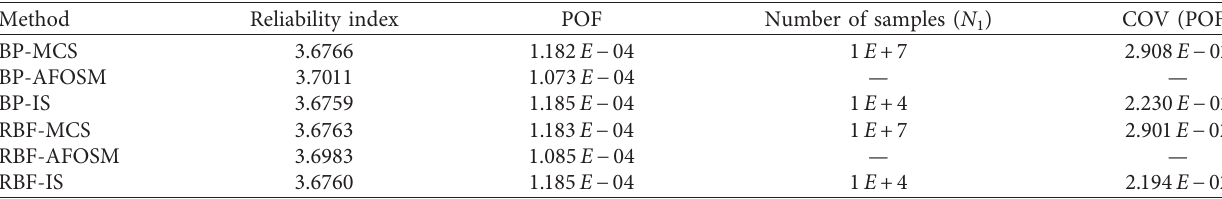
Table 10: Comparison of the reliability index and POF from different reliability analysis methods with an ANN sample size of 200. Method